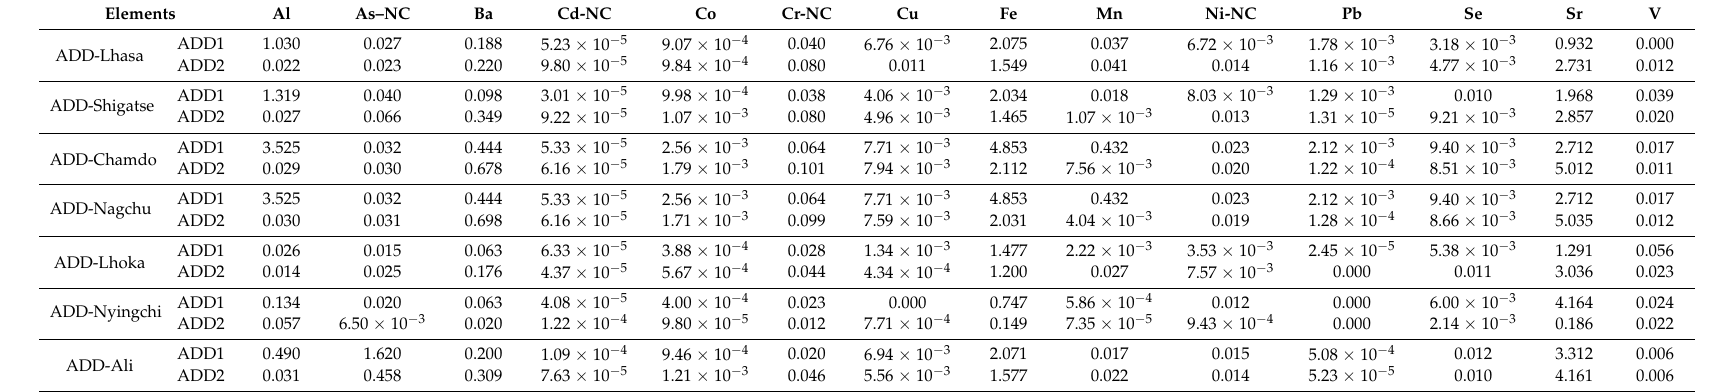
Table 2. The average daily dose of limited indicators from ingestion of Tibet’s natural